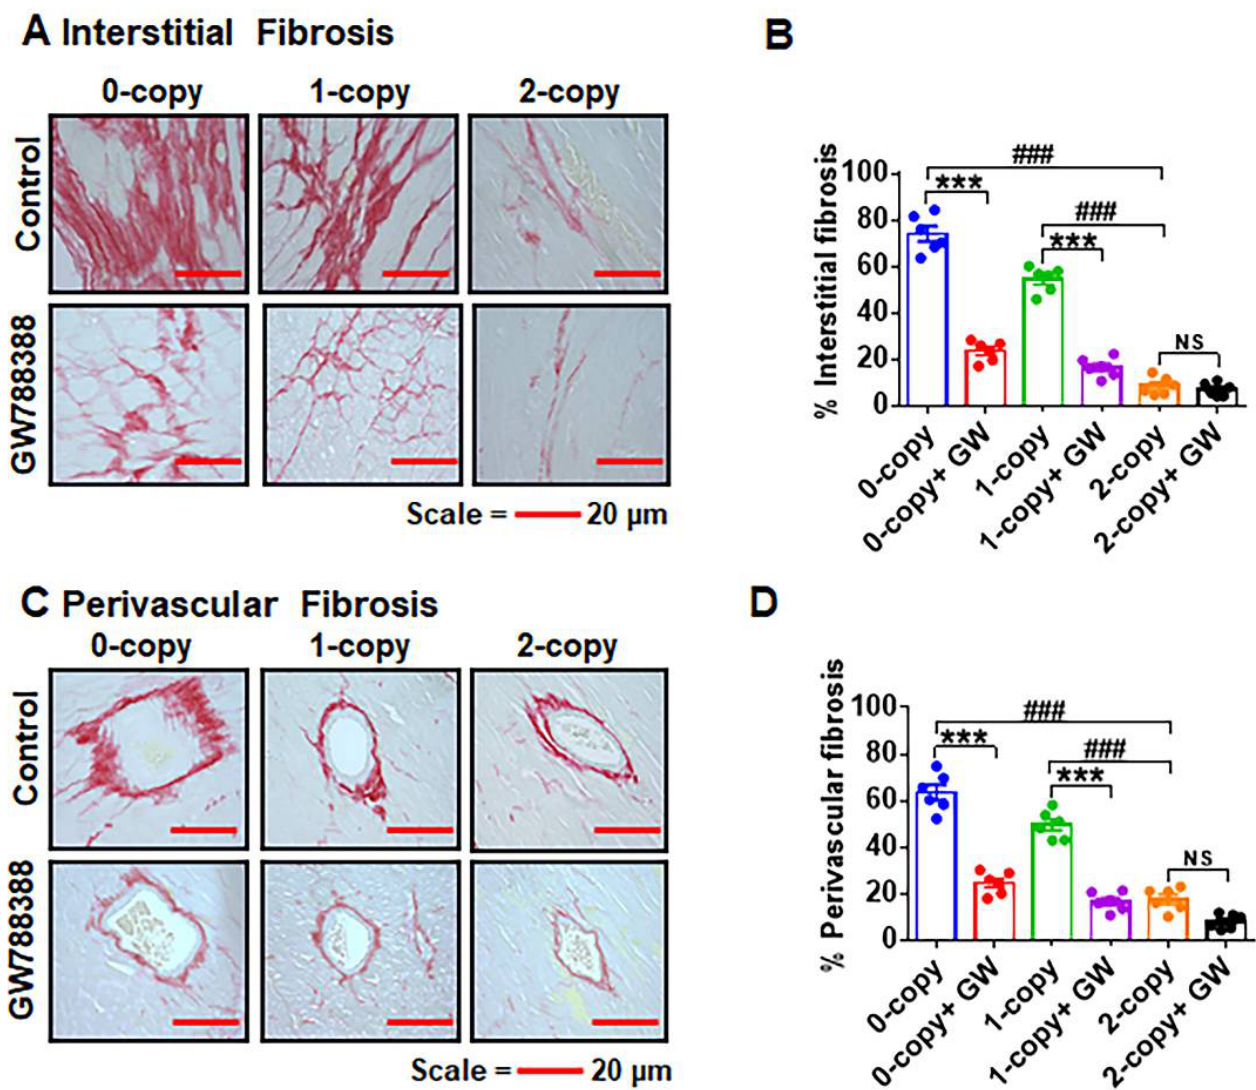
Figure 7. Analysis of interstitial and perivascular fibrosis in the control and drug-treated male Npr1 gene-ablated mouse heart: Representative heart tissue sections for interstitial fibrosis from control and drug-treated male mice were stained with picrosirius red staining (panels ( A , B )). The red color is indicative of fibrosis. Similarly, the representative heart tissue sections for perivascular fibrosis are presented from control and drug-treated mice (panels ( C , D )). Values are expressed as means ± S.E. (n = 6 animals in each group). Statistical significance is expressed as ### p < 0.001, vehicle-treated 0-copy and 1-copy vs. 2-copy; *** p < 0.001, vehicle-treated 0-copy,1-copy and 2 copy vs. drug-treated same gene copy number. NS: not significant.